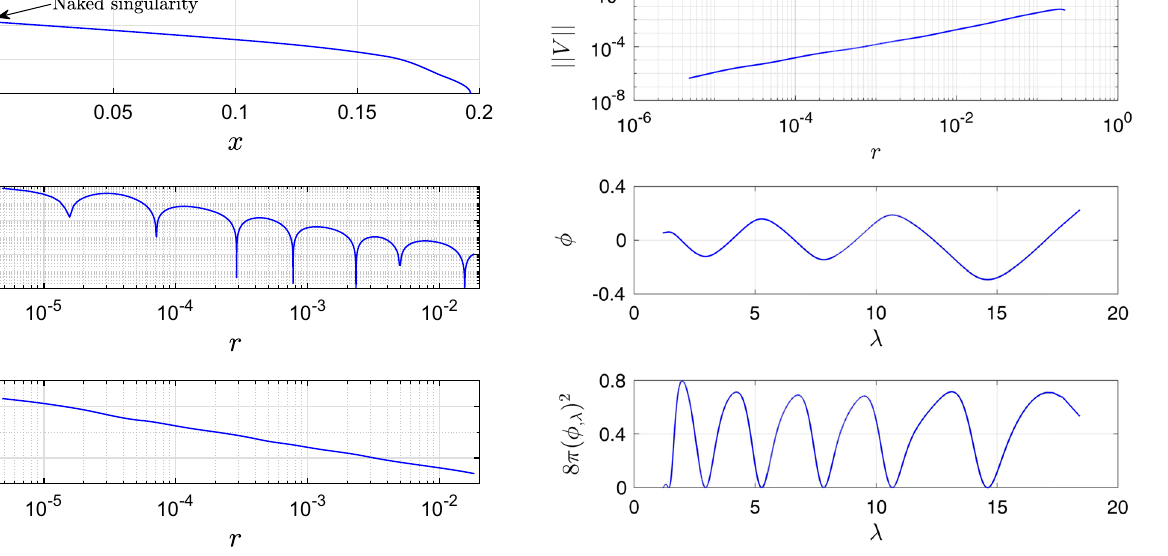
Fig. 2 Upperpanel:onetimelikegeodesicterminatingatthenakedsin- gularity. Middle and lower panels: the Ricci scalar R and Kretschmann scalar K along the geodesic